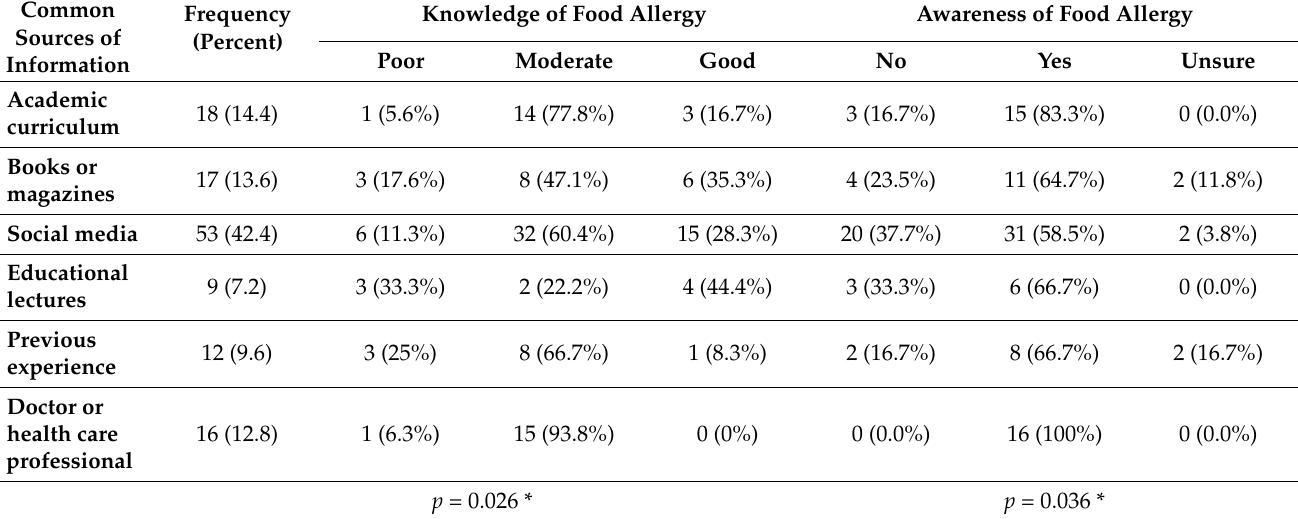
Table 7. Association of source of information about food allergy with knowledge score and awareness of food